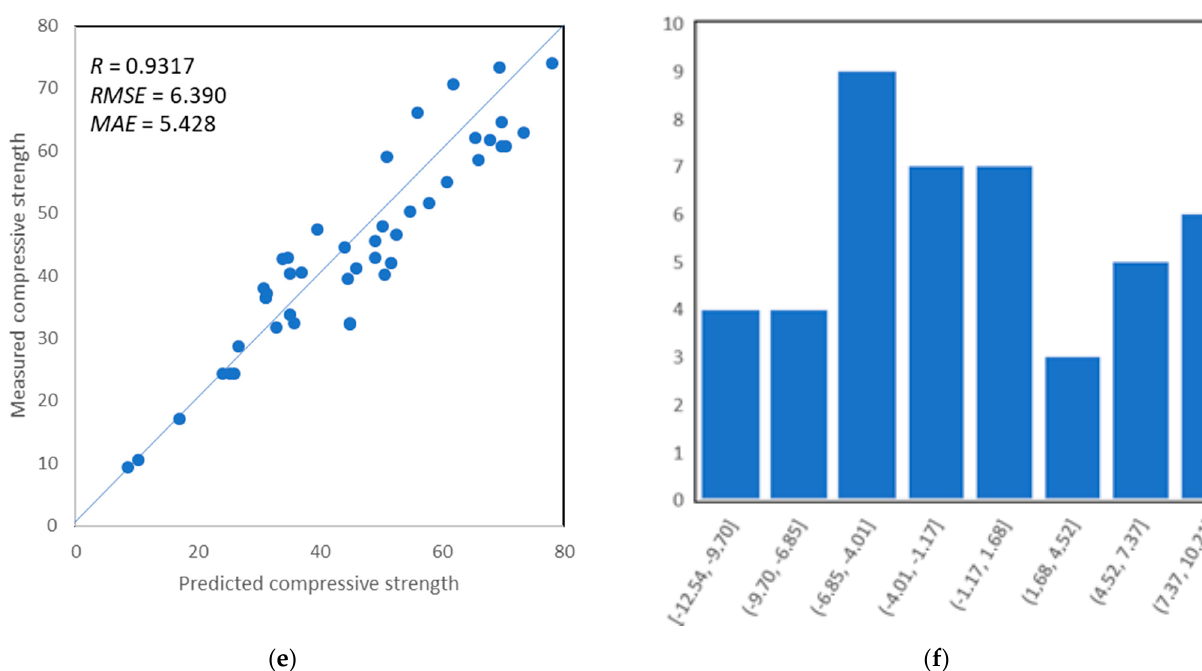
Figure 7. ( a ) Predictions vs. target data of training set; ( b ) error distribution of ANN model with prediction versus training set; ( c ) predictions vs. target data of validation set; ( d ) error distribution of ANN model with prediction versus validation set; ( e ) predictions vs. target data of testing set; ( f ) error distribution of ANN model with prediction versus testing set.